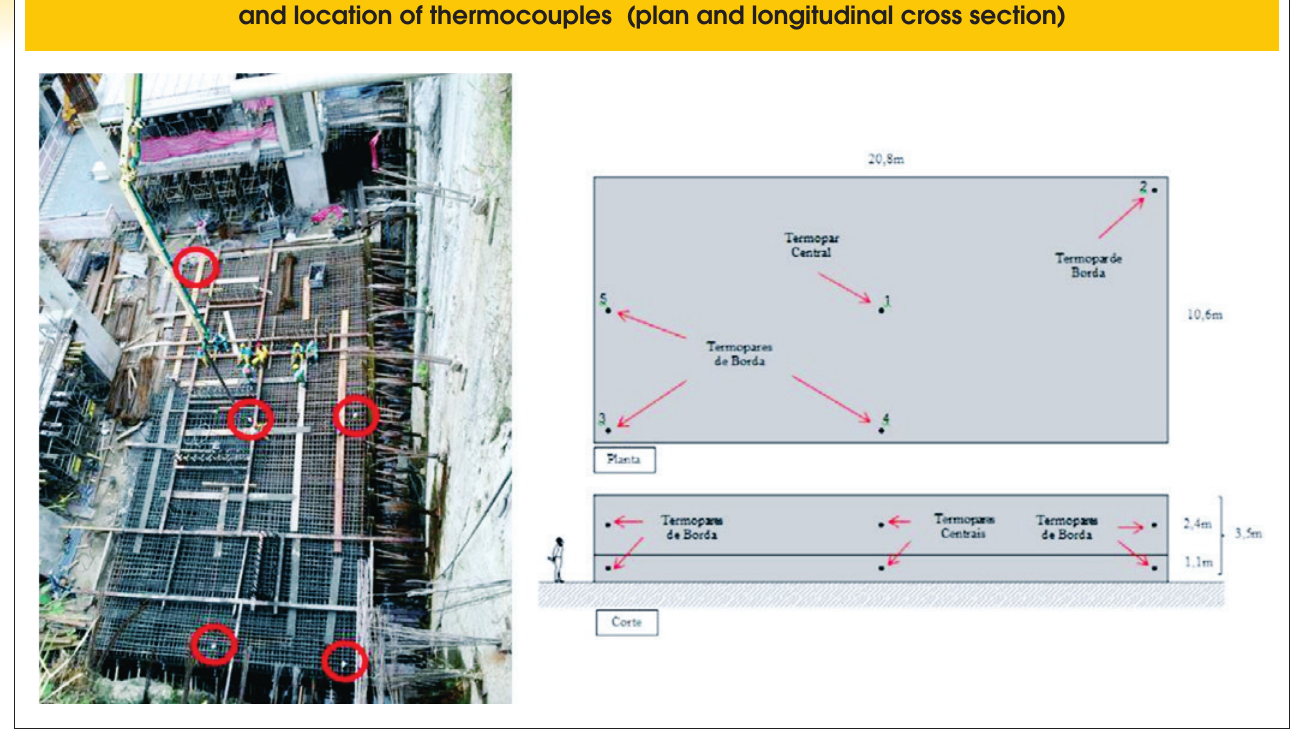
Figure 3 – Top view of spread footing before pouring the first layer and location of thermocouples (plan and longitudinal cross section)